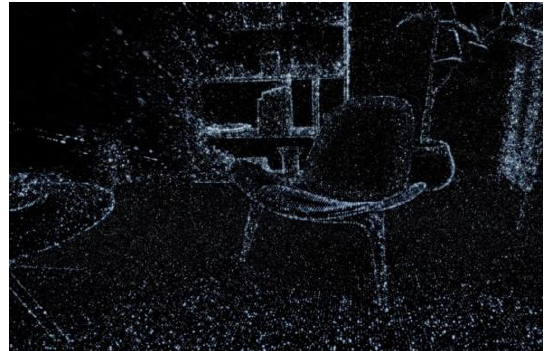
Figure 2. Generated 3D model of the room using the LIDAR